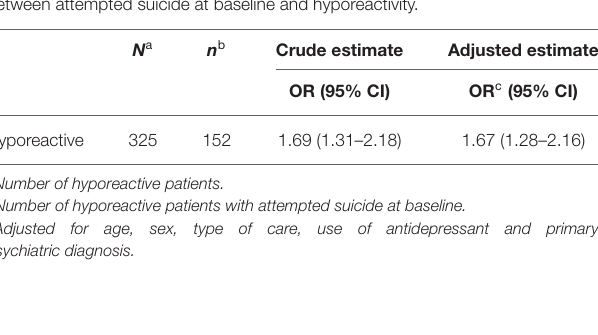
TABLE 9 | Odds ratio (OR) and 95% confidence intervals (CI) of the association between attempted suicide at follow-up using hyporeactivity and attempted suicide at baseline as independent